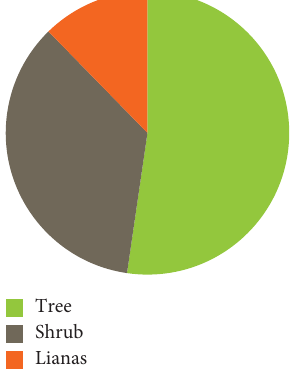
Figure 3: Growth forms of